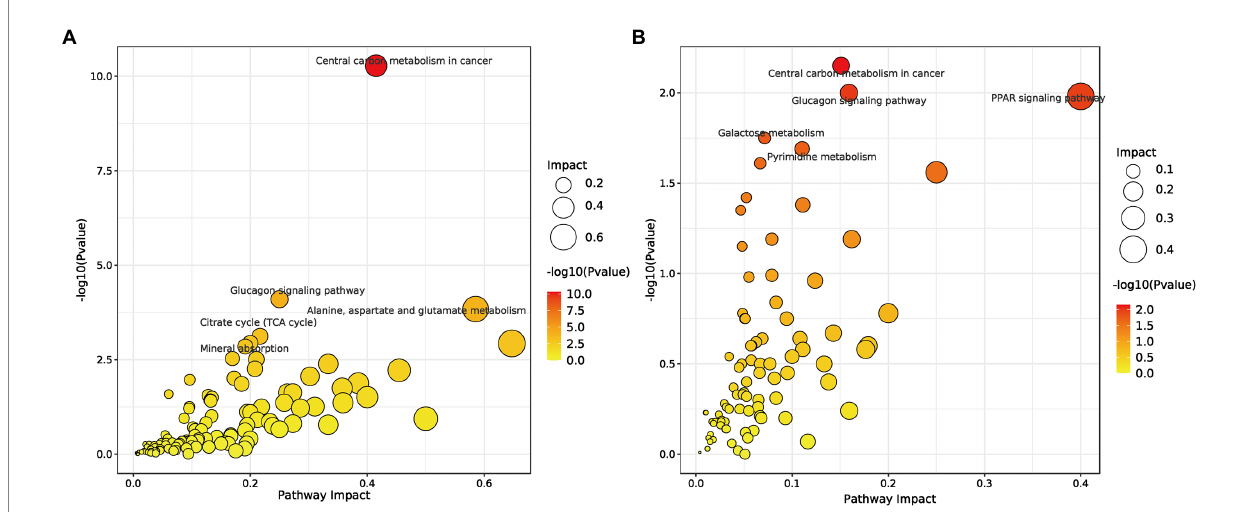
FIGURE 6 Metabolic pathways. (A) Summary of pathway analysis of serum samples between Sham and CLP groups. (B) Summary of pathway analysis of serum samples between CLP and SFH groups. Sham, CLP, and SFH groups ( n = 8 per